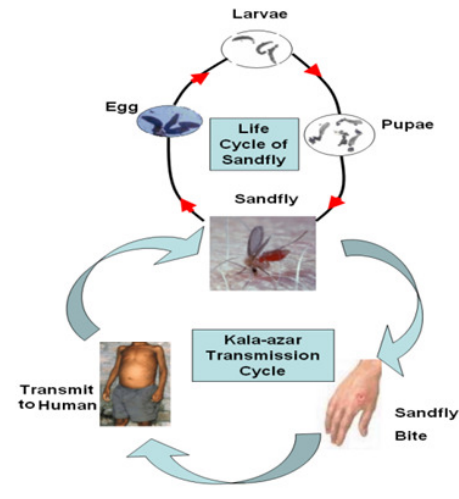
Fig. 1. Disease Transmission cycle of